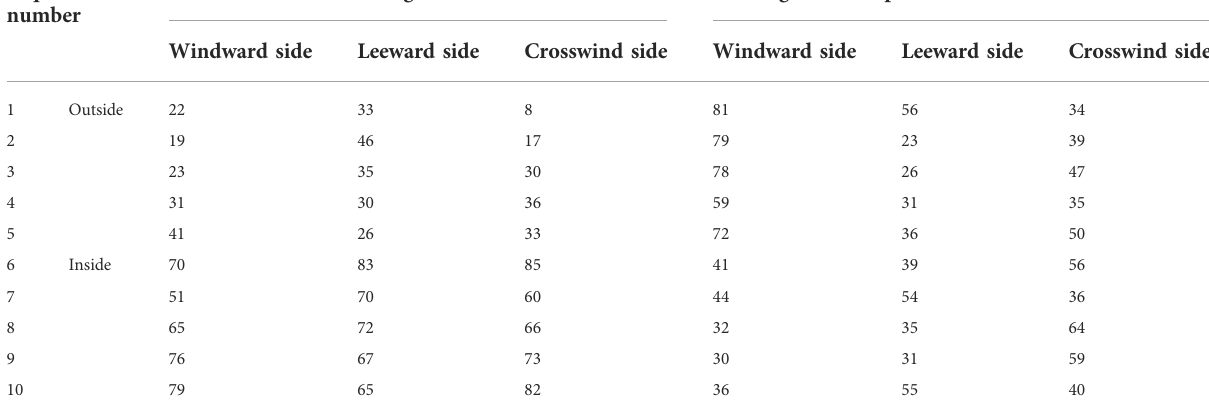
TABLE 1 The branching angle of samples of Artemisia ordosica .